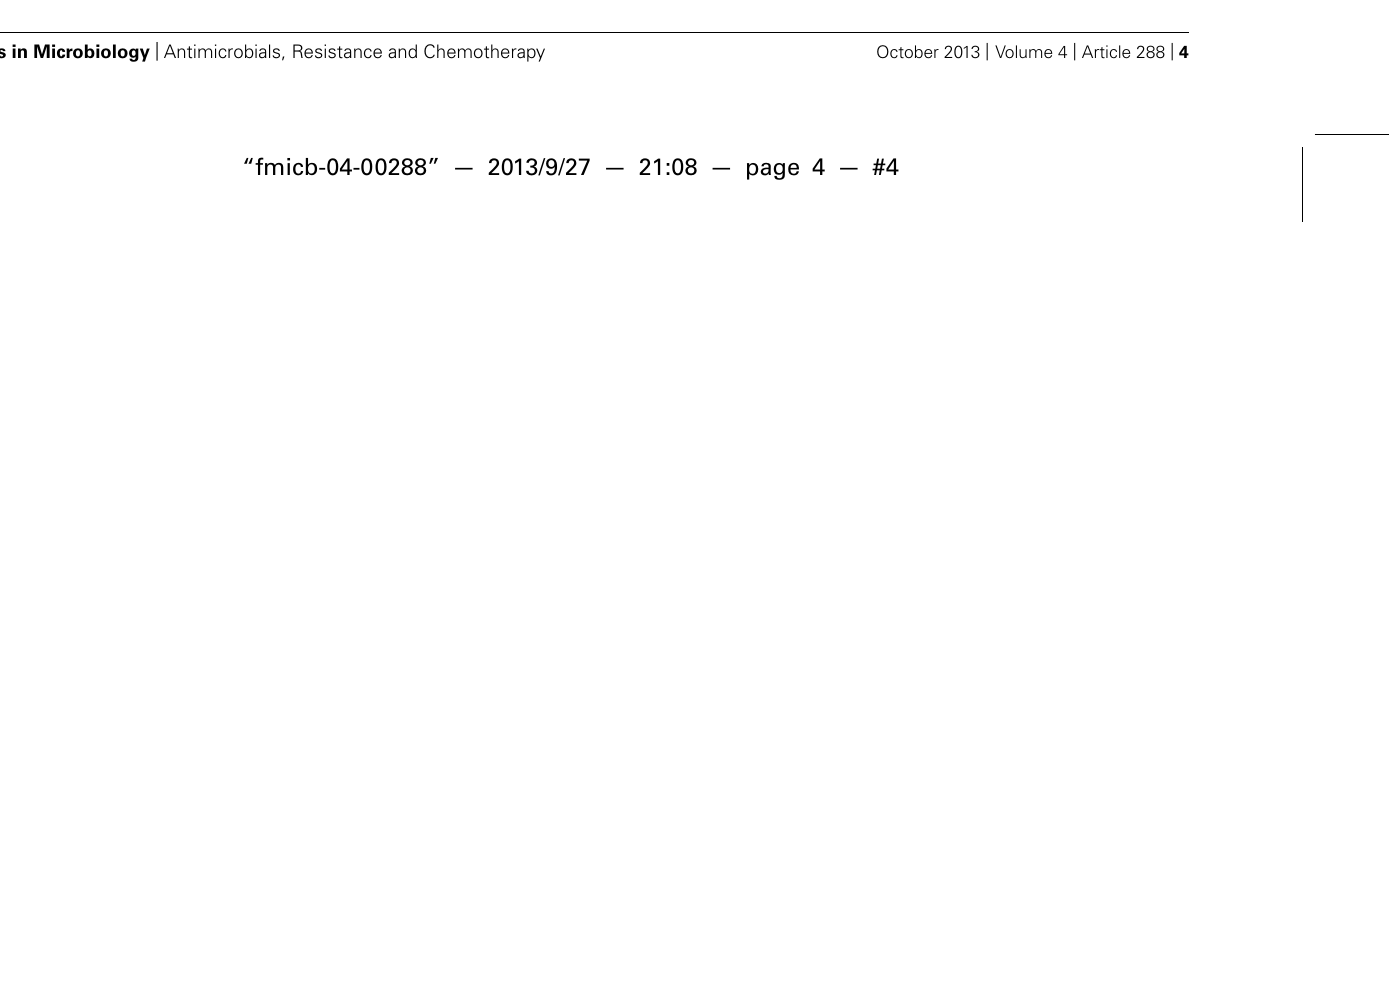
AMP, ampicillin; AZT, azithromycin; CAZ, ceftazidime; CHL, chloramphenicol; CIP, ciprofloxacin; CRO, ceftriaxone; FZD, furazolidone; GEN, gentamicin; NAL, nalidixic acid; STX, trimethoprim–sulfamethoxazole;TET, tetracycline. *Includes resistant and intermediate strains. † Difference from 2005 to 2011: p <